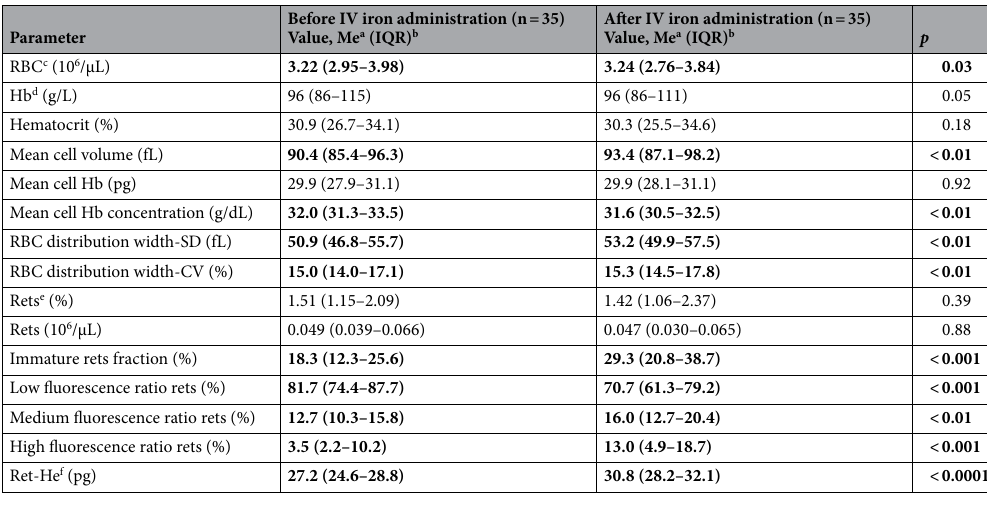
Table 4. Differences in erythrocyte and reticulocytic indices before the administration of intravenous iron dextran and after two doses of iron dextran. Significant values are in [bold]. a Median value. b Interquartile range. c Red blood cell. d Hemoglobin. e Reticulocytes. f Reticulocyte hemoglobin equivalent.